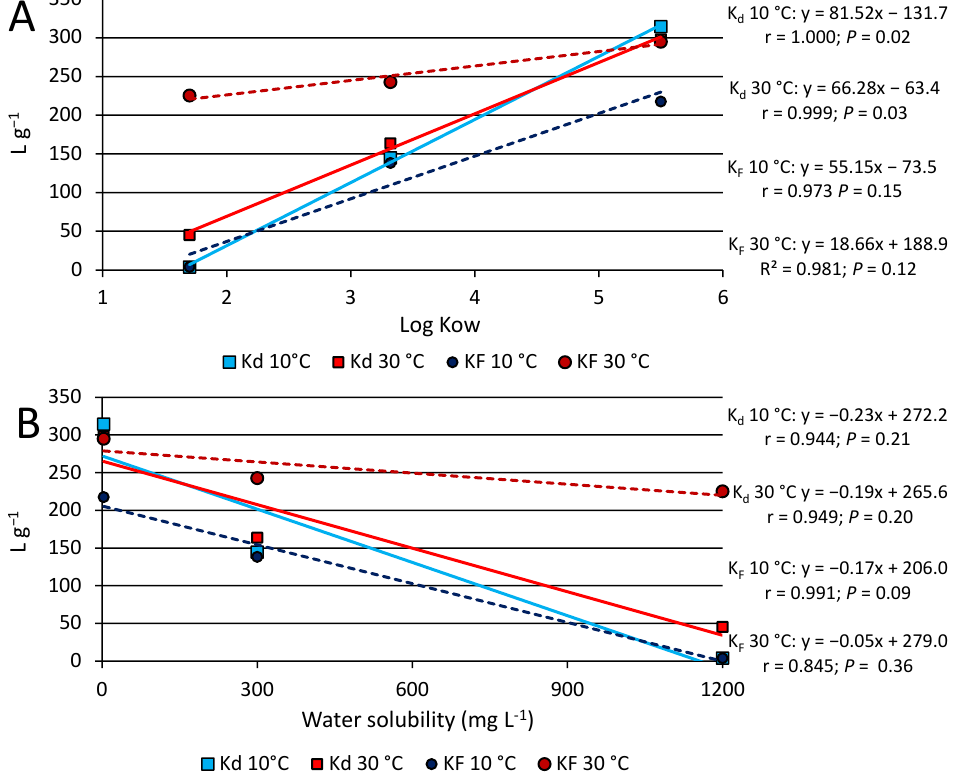
Figure 9. Percentage of compound that remains adsorbed on biochar after each desorption step. Standard error is reported as vertical bar on each point (n = 3).